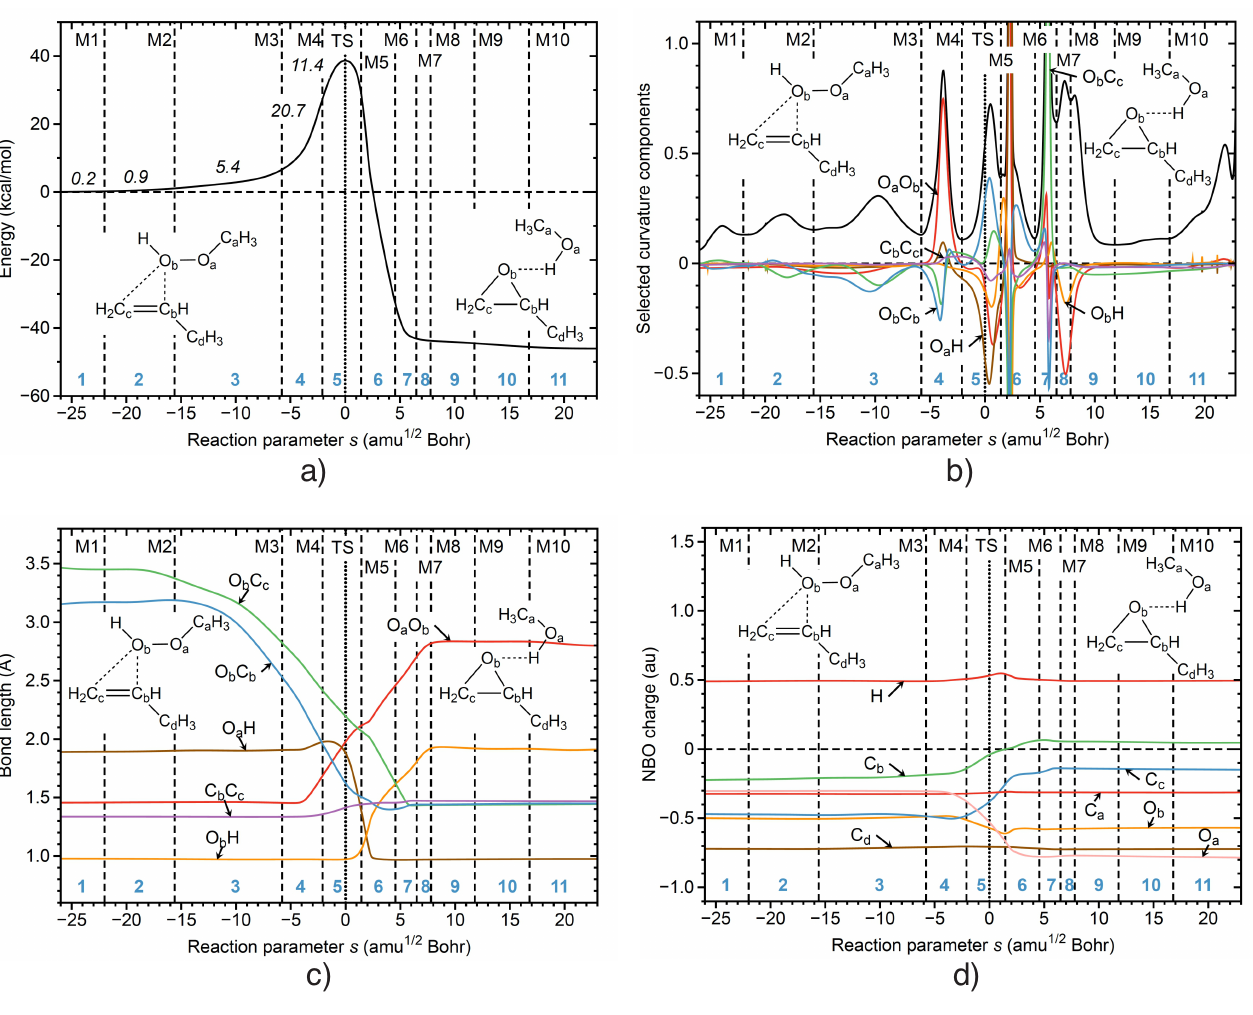
d) Figure 3. Properties of reaction R0 along the reaction path. ( a ) Energy profile, where the energy contributions of each reaction phase to the activation energy are indicated by italic numbers. ( b ) De- composition of the reaction curvature into selected geometry components. ( c ) Change of selected bond lengths. ( d ) Change of selected NBO atomic charges. The curvature minima are shown as broken vertical lines and are labeled as M1, M2 and so on. The position of TS is indicated as a dotted line. The reaction phases are indicated by blue numbers. B3LYP/6-31G(d,p)/SDD(Ti) level of theory. Although OO bond breakage continues in phases 5 and 6, the large curvature peaks in these phases are dominated by formation of the O b C b and O b C c bonds. The distances of both CO bonds continuously decrease from their starting values of 3.2 Å for O b C b and 3.5 Å for O b C c , respectively, with the steepest decline in phases 3 to 6, reaching their final values of 1.5 Å at the beginning of phase 7 (see Figure 3c), in line with the finalization of the CO epoxide bond formation indicated by large contributions of the O b C b and O b C c distances to the reaction path curvature in this phase. As of the asymmetric approach of the peroxide to the alcohol, the O b C b bond formation slightly preceeds the O b C c